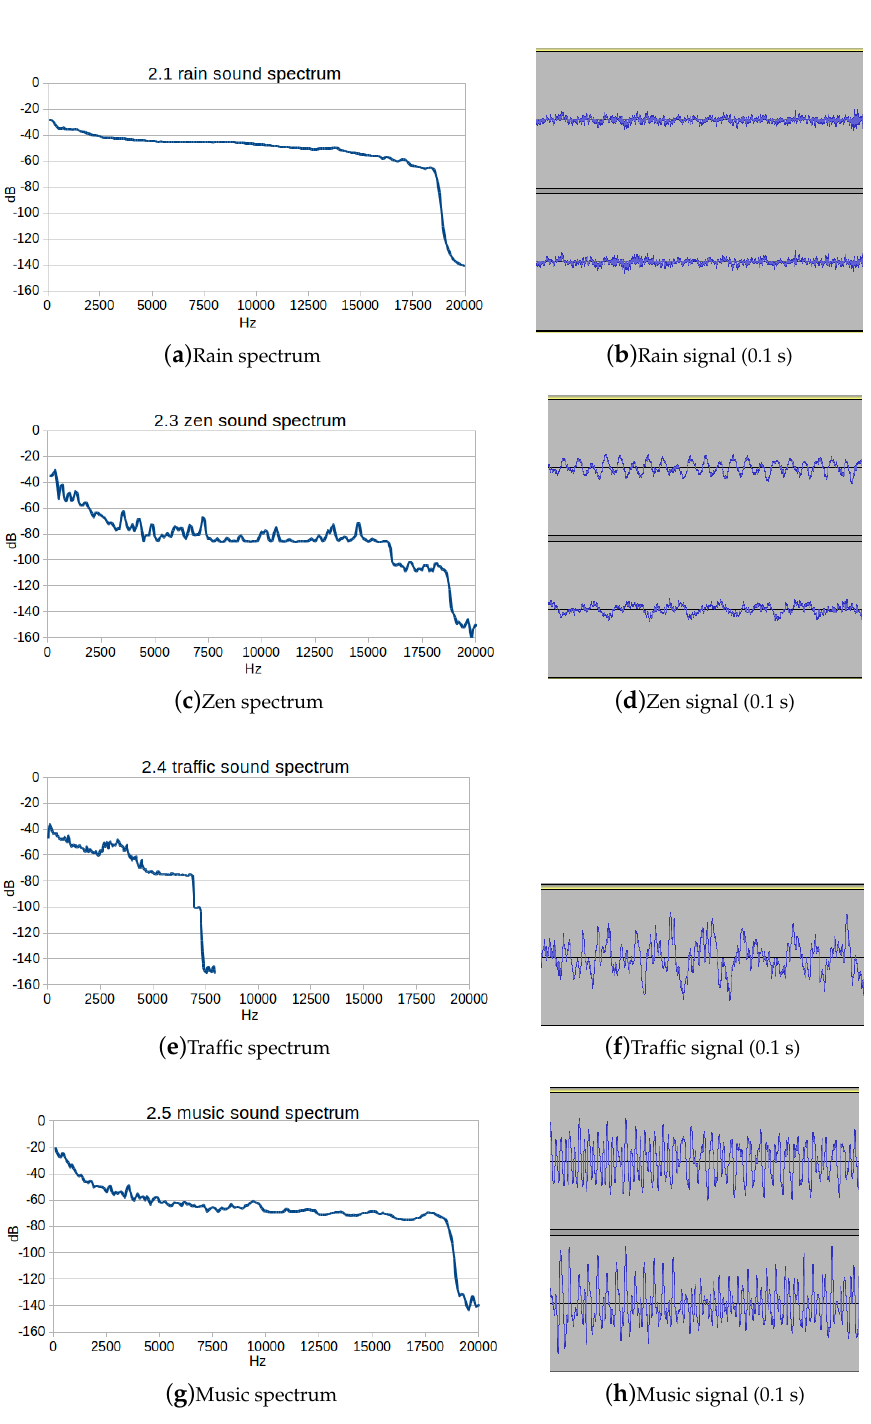
Figure A1. The spectrums of the test